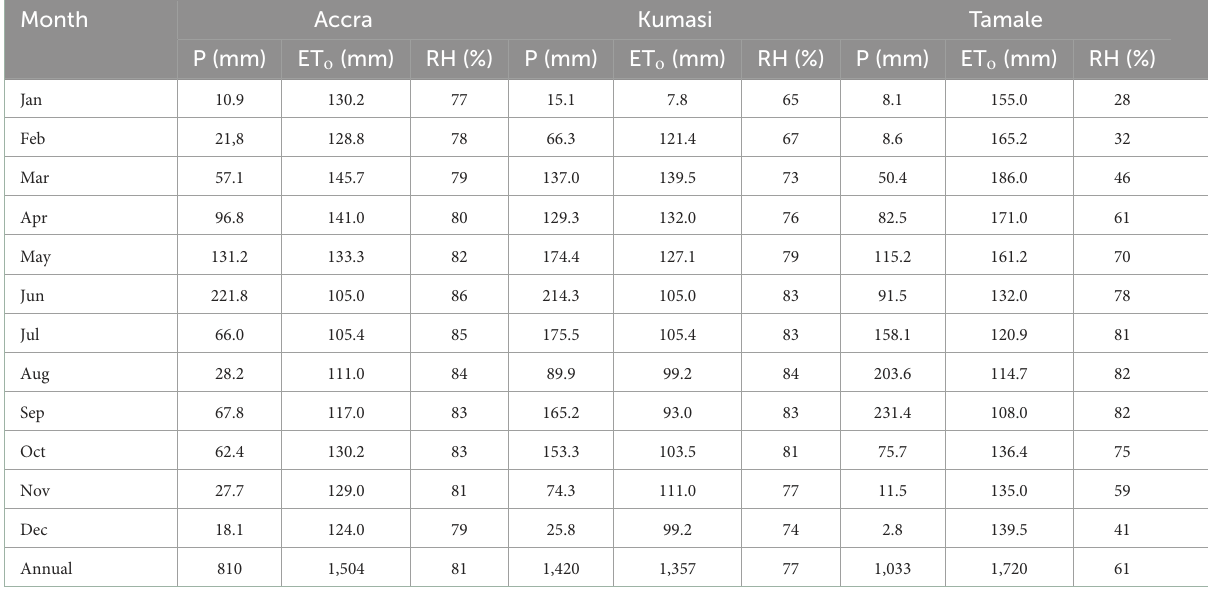
TABLE 1 Rainfall, potential evapotranspiration and relative humidity for Accra, Kumasi, and Tamale. Month